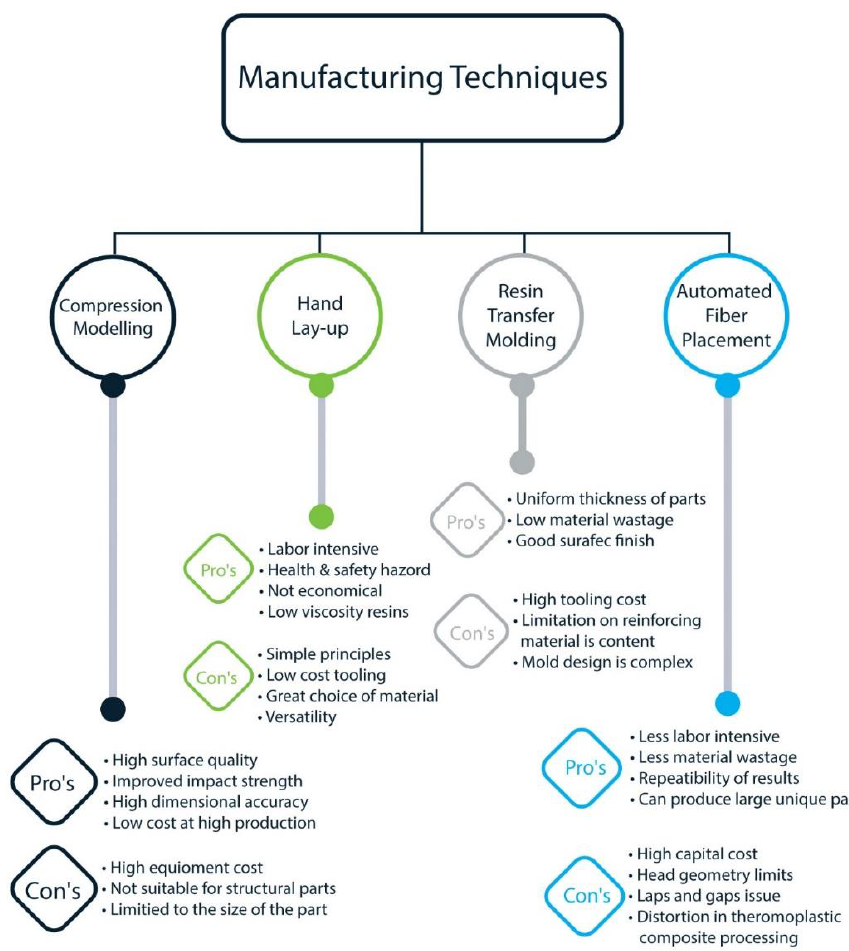
Figure 6. Different Manufacturing techniques for producing natural fiber composites (NFCs).